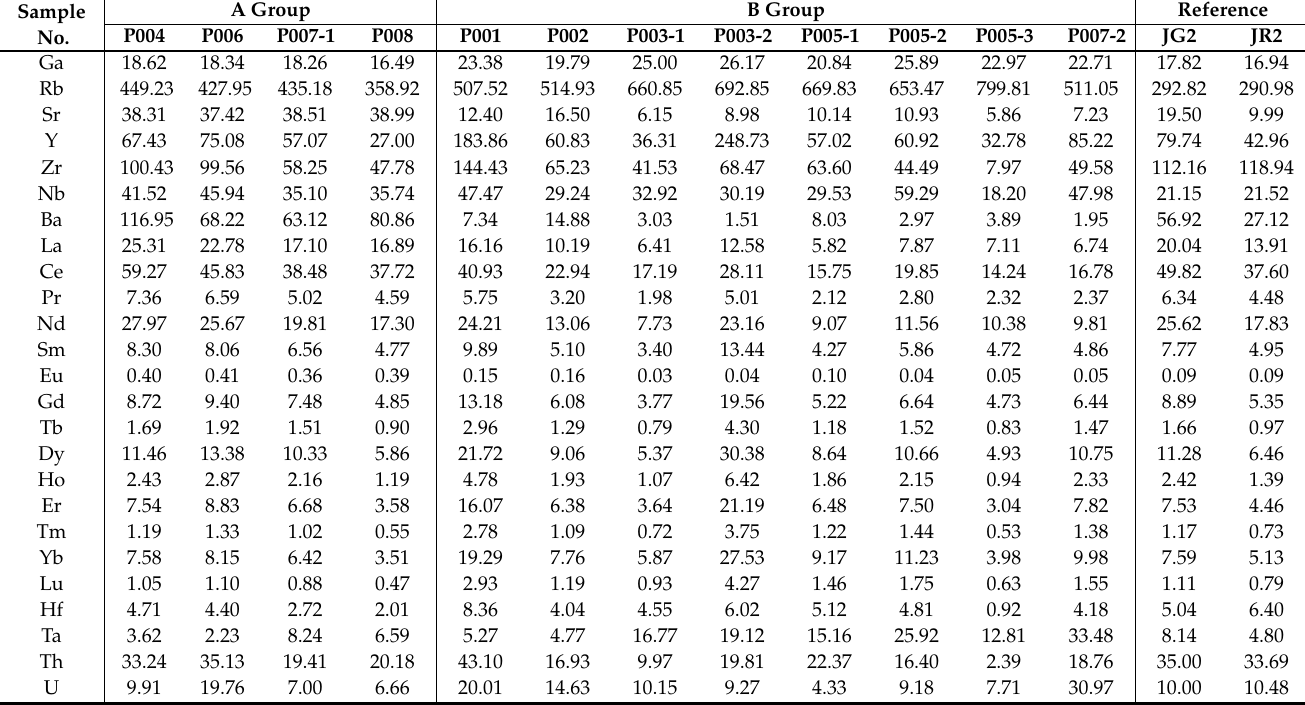
Table 1. Trace and REE concentrations (ppm) for Pirrit Hills granite samples.